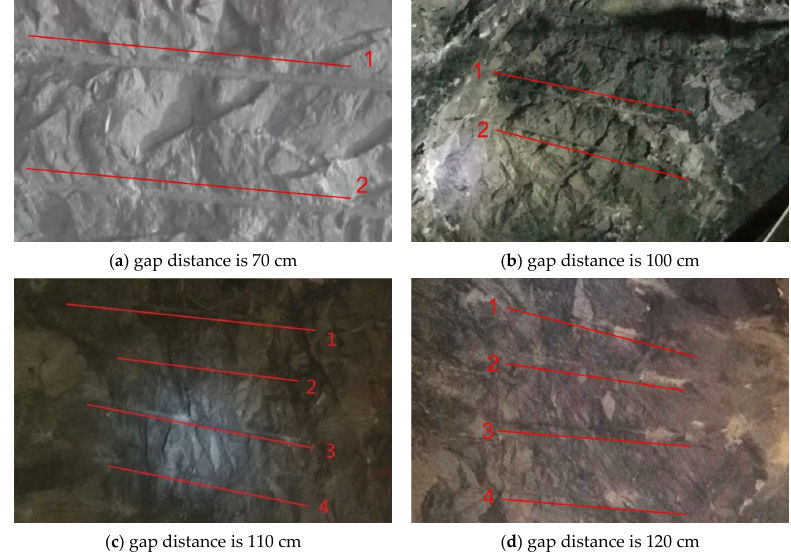
Figure 4. The traces of blastholes of various gap distances on sympathetic detonation. ( a ) gap distance is 70 cm, ( b ) gap distance is 100 cm, ( c ) gap distance is 110 cm, ( d ) gap distance is 120 cm.